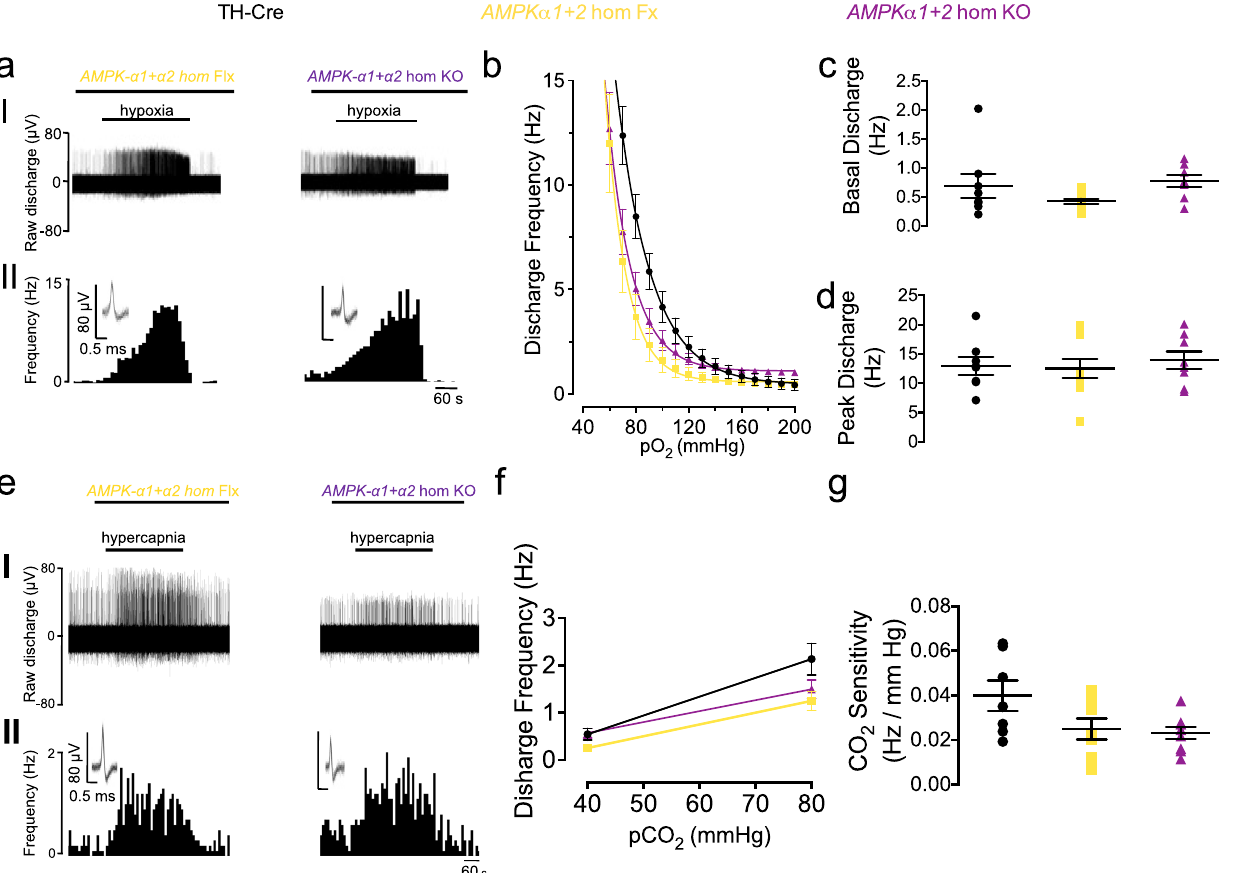
Fig. 4 Conditional deletion of AMPK- α 1 + α 2 in carotid body type I cells has no effect on hypoxia-evoked or hypercapnia-evoked afferent discharge from the carotid body in vitro. a Shows (I) extracellular recordings of chemoafferent discharge versus time during normoxia and hypoxia and (II) frequency-time histograms ( inset: single fi bre discriminations) for carotid bodies from AMPK α 1 + α 2 homozygous fl oxed (AMPK α 1 + α 2 hom Fx, beige; n = 9 different carotid bodies) and conditional homozygous AMPK α 1 + α 2 knockout mice ( AMPK α 1 + α 2 hom KO, purple; n = 9 different carotid bodies). b Means±SEM for frequency- P O 2 response curves for AMPK α 1 + α 2 hom Fx and AMPK α 1 + α 2 hom KO. c , d Dot plots show mean ± SEM for c basal single fi bre discharge frequency and d peak single fi bre discharge frequency during hypoxia for controls TH-Cre, black; n = 8 different carotid bodies), AMPK α 1 + α 2 hom Fx and AMPK α 1 + α 2 hom KO. e as for a but in response to hypercapnia. f Means±SEM for frequency- PC O 2 relationship. g Dot plot shows mean ± SEM for CO 2